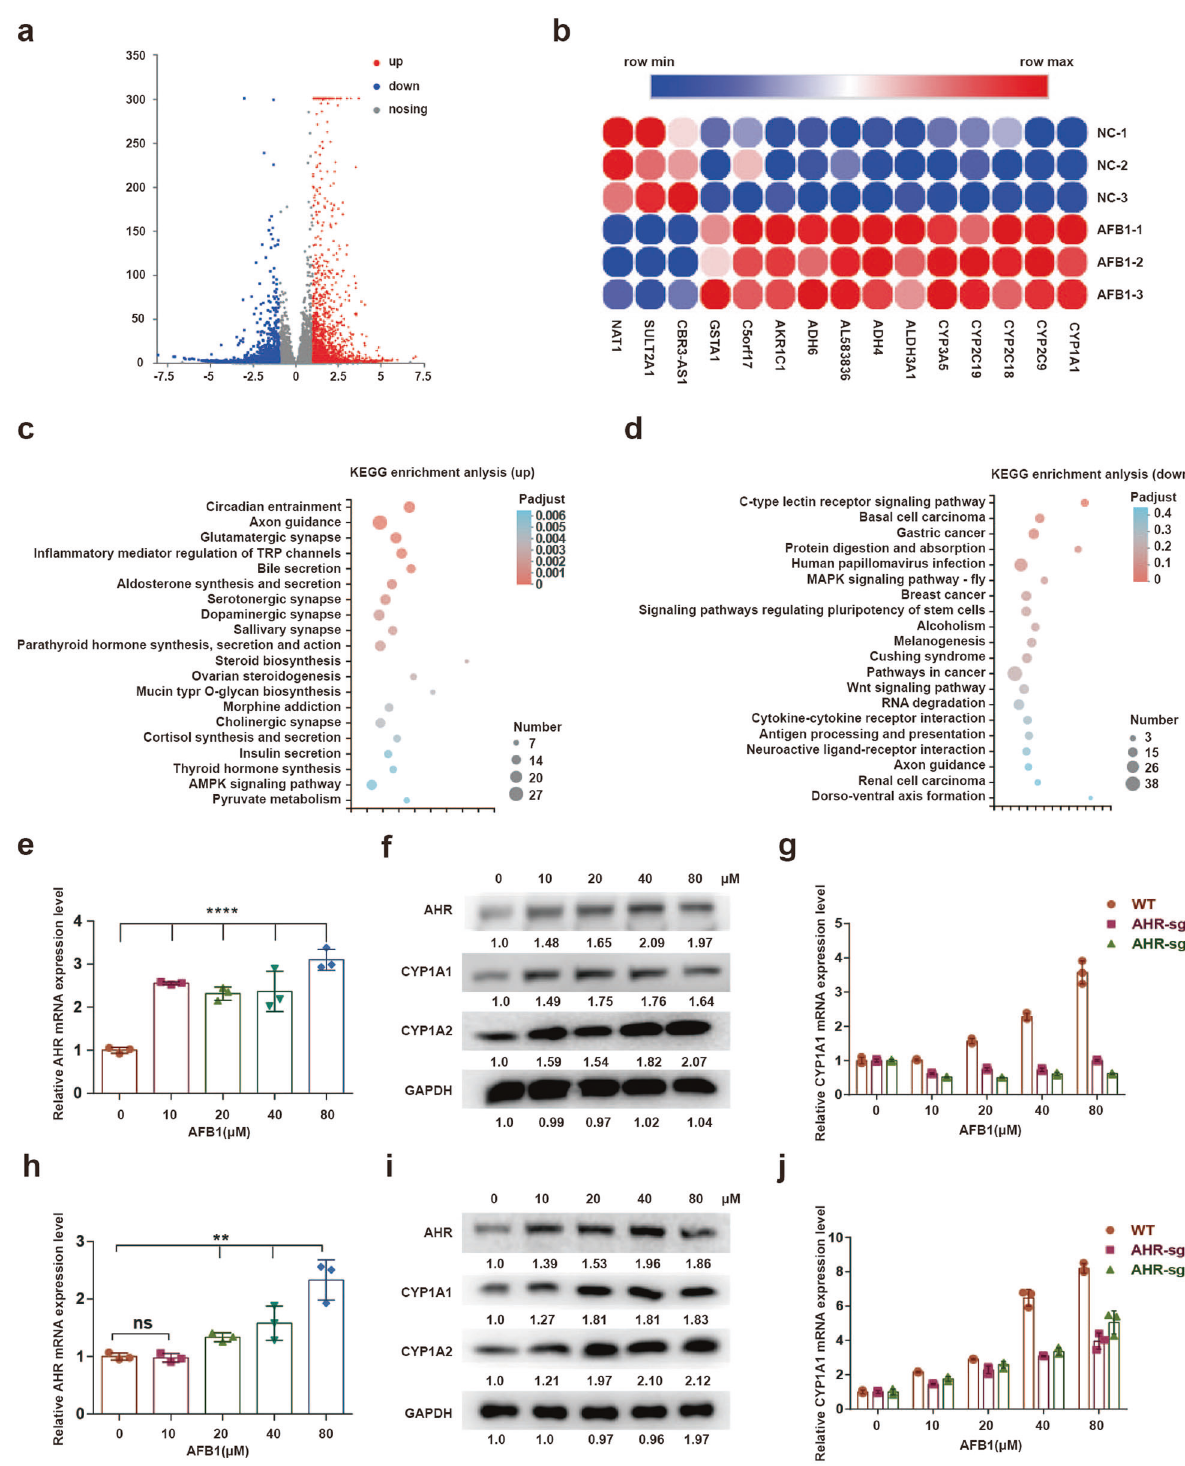
Fig. 4 AFB1 activates AHR -dependent gene expression in hepatocellular carcinoma cell lines. a Volcano plot showing differentially expressed genes upon AFB1 treatment. Blue dots represent downregulated genes (FDR ≤ 0.05, fold change <0.5) and red dots indicated upregulated genes (FDR ≤ 0.05, fold change >2). b The heatmap of differentially abundant genes was obtained from the NC (PLC/PRF/5 cells treated with DMSO) and AFB1 (PLC/PRF/5 cells treated with 20 µM AFB1) treated groups. c Signi fi cantly upregulated KEGG pathways with AFB1 treatment. d Signi fi cantly downregulated KEGG pathways with AFB1 treatment. e qPCR to determine AHR mRNA expression levels treated with AFB1 in PLC/PRF/5 cells. f Western blot analysis for AHR, CYP1A1, and CYP1A2 in PLC/PRF/5 cells. g qPCR to determine CYP1A1 expression levels in AHR WT and AHR KD PLC/PRF/5 cells treated with AFB1. h qPCR to determine AHR mRNA expression levels in HuH7 cells treated with AFB1. i Western blot analysis for AHR, CYP1A1, and CYP1A2 in HuH7 cells. j qPCR to determine expression levels of CYP1A1 in AHR WT and AHR KD HuH7 cells treated with different concentrations of AFB1